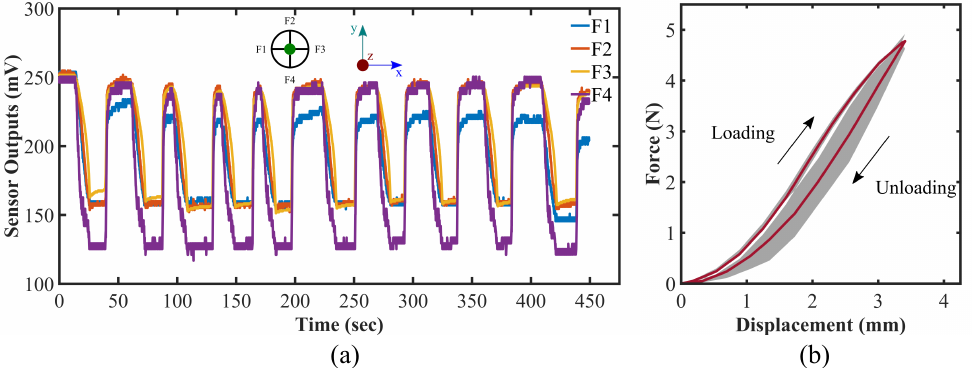
Figure 12. ( a ) Cyclic loading test and ( b ) hysteresis test results; green dot in ( a ) representing the exerted force direction along z-axis, and shaded area in ( b ) depicting the standard deviation of force for a certain displacement